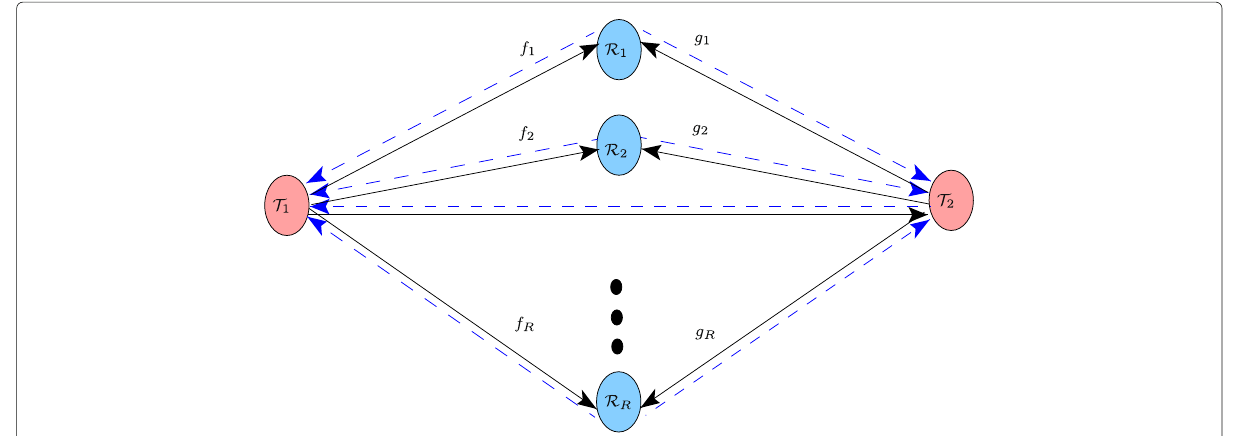
Fig. 1 Two-way wireless relay network with ( R + 2)